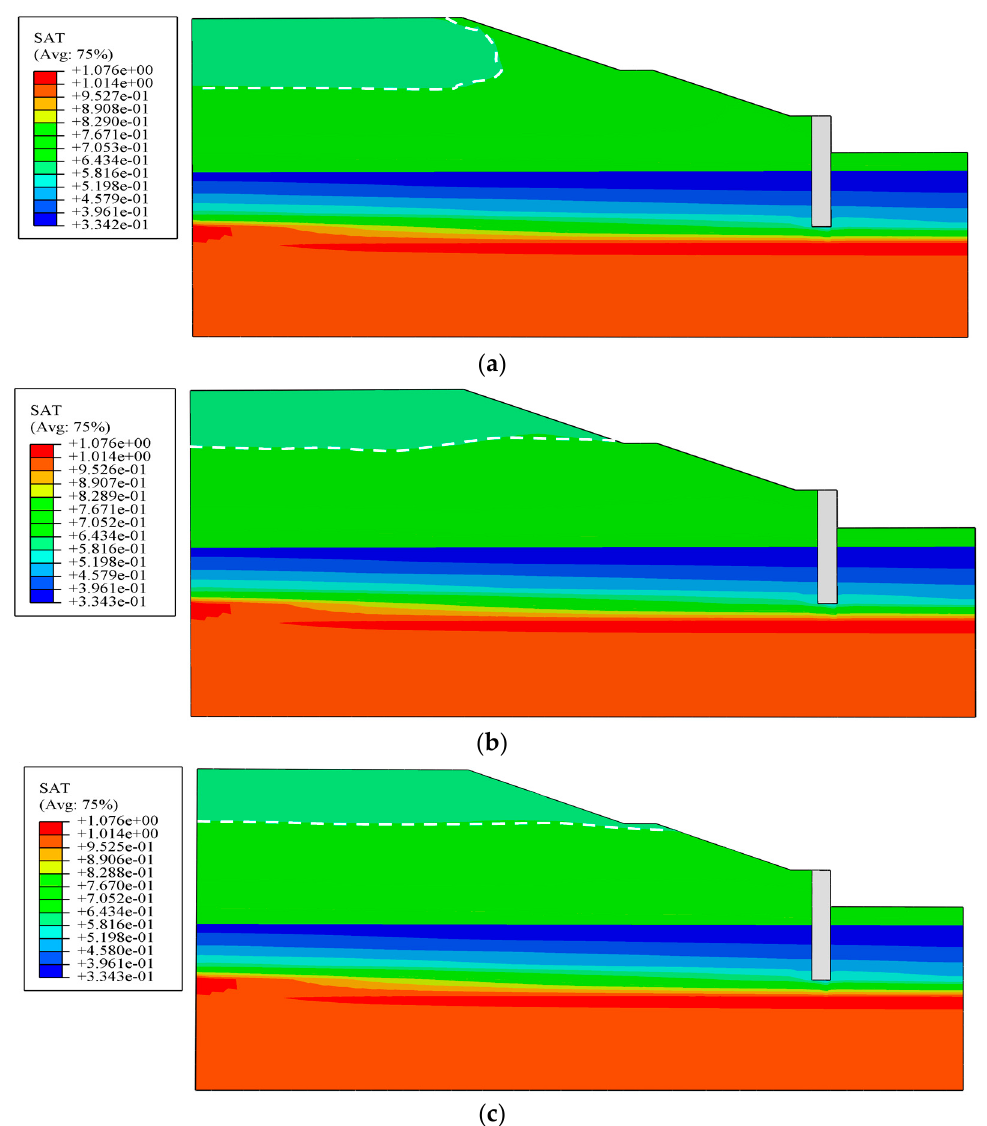
Figure 9. The degree of saturation ( S r ) contours of the cutting slope under the snowmelt infiltration: ( a ) t = 48 h; ( b ) t = 72 h; and ( c ) t = 96